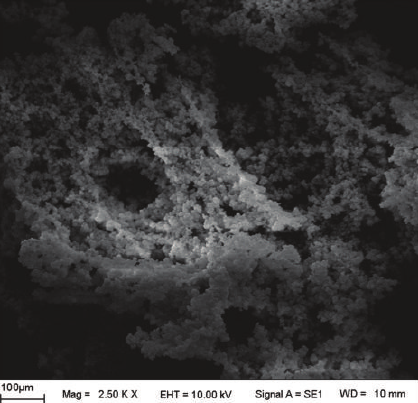
Figure 3: SEM photograph of the poly(MMA- co- GMA)